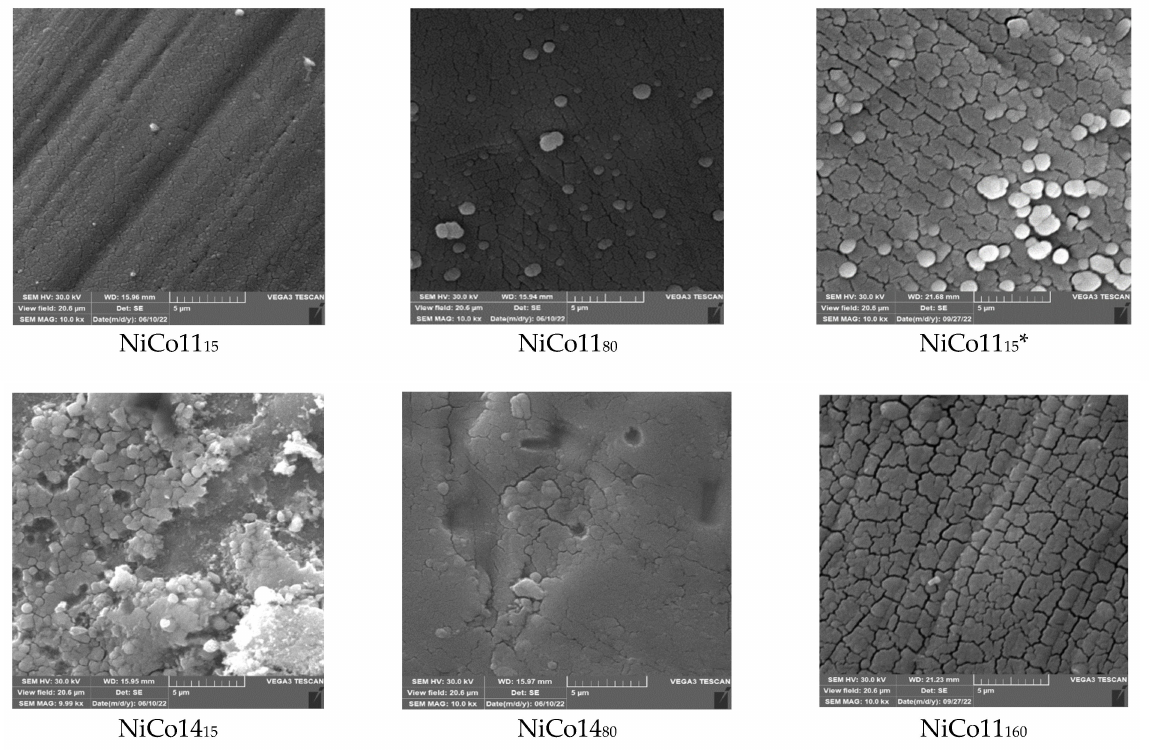
Figure 3. SEM images of catalysts prepared under different plasma sputtering